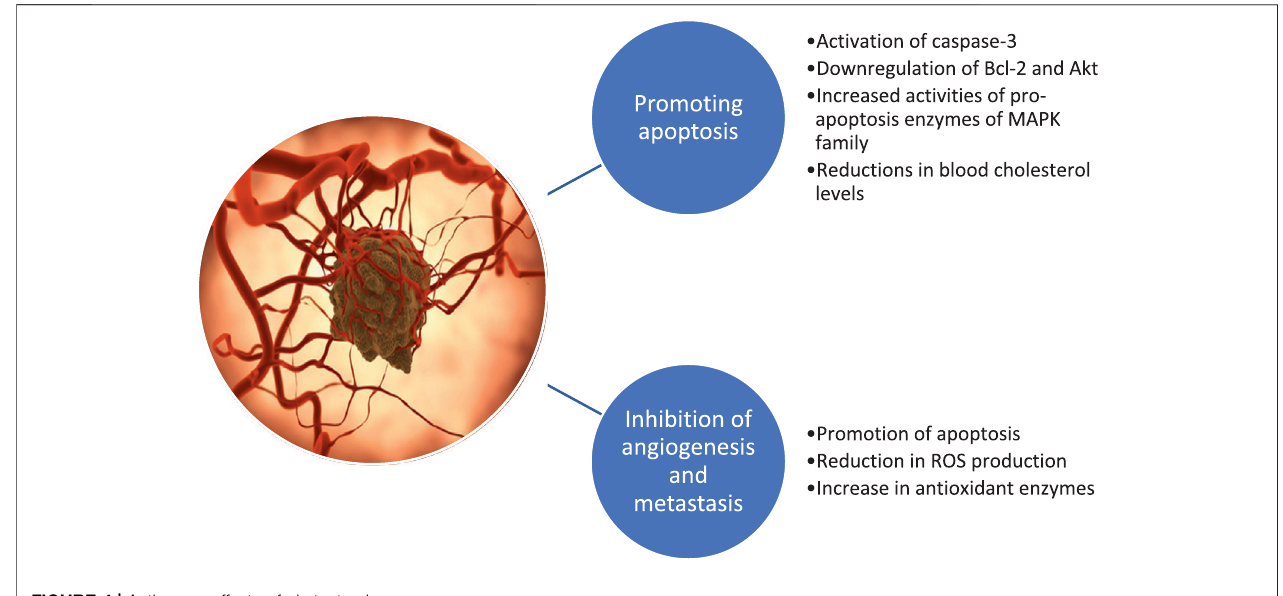
FIGURE 4 | Anticancer effects of phytosterols.